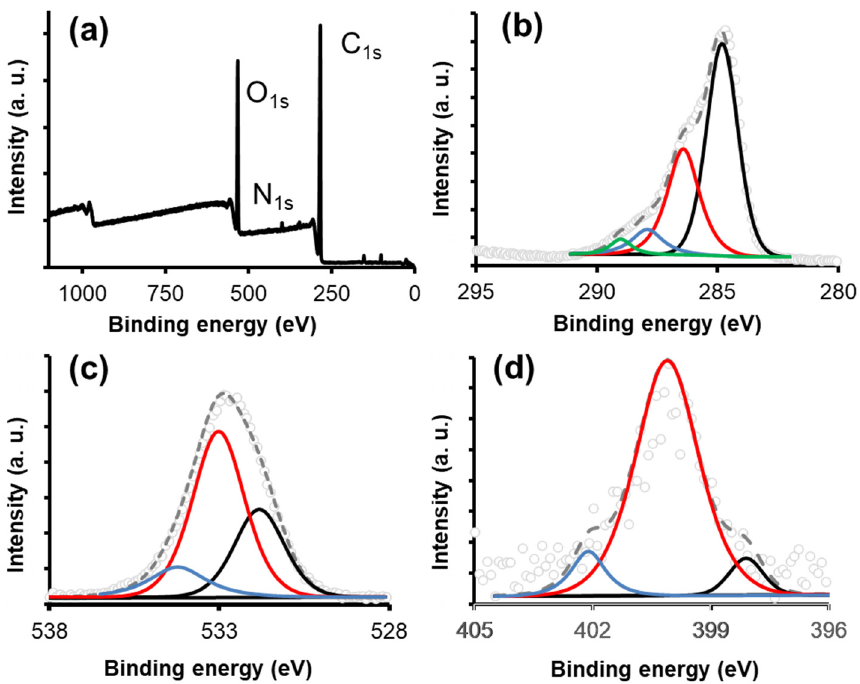
Figure 5. Deconvolution of the XP spectra of the agave bagasse. ( a ) XPS survey spectra, ( b ) C 1s XPS spectrum: C-C bond (black line), C-O bond (red line), C=O bond (blue line), and O-C=O bond (green line) ( c ) O 1s XPS spectrum; C=O bond (Black line), C-O bond (red line), and O-H bond (blue line), and ( d ) N 1s XPS spectrum: Amide bond (black line and red line) and NH 3+ bond (blue line). Experimental data (dotted line), fitting curve (Dashed line). Table 2. Binding energies (eV) of the C 1s , O 1s , and N 1s regions obtained from the mathematical analyses of the XP